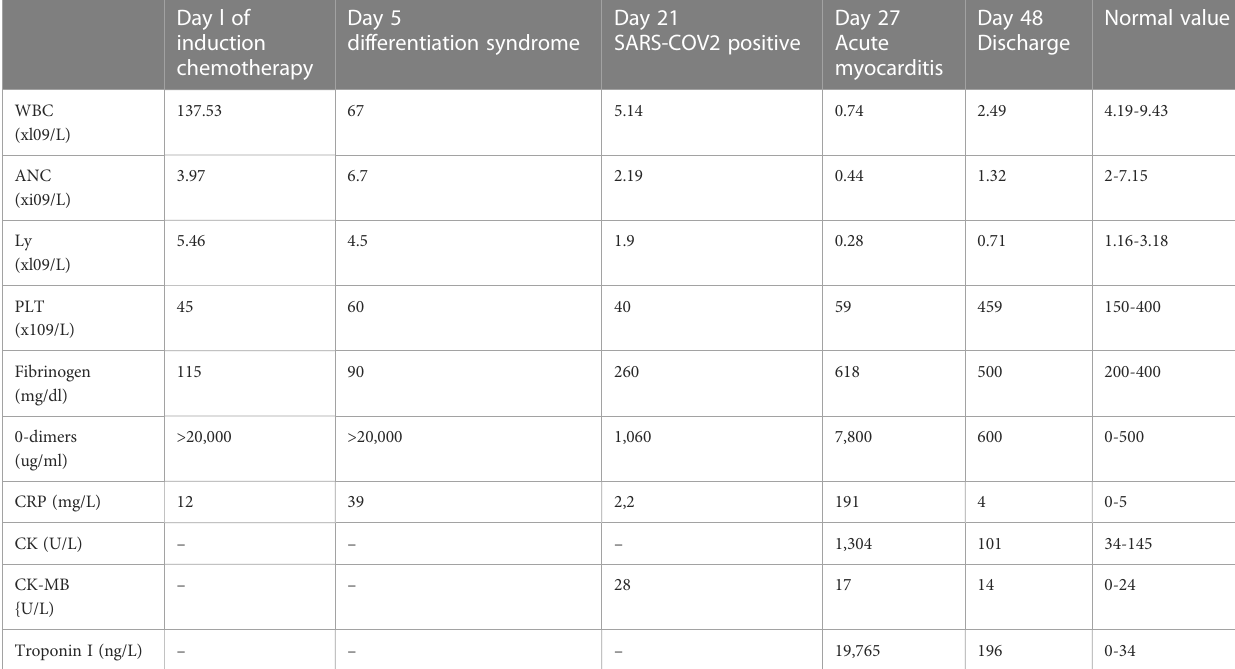
TABLE 1 Laboratory parameters trends during hospitalization.